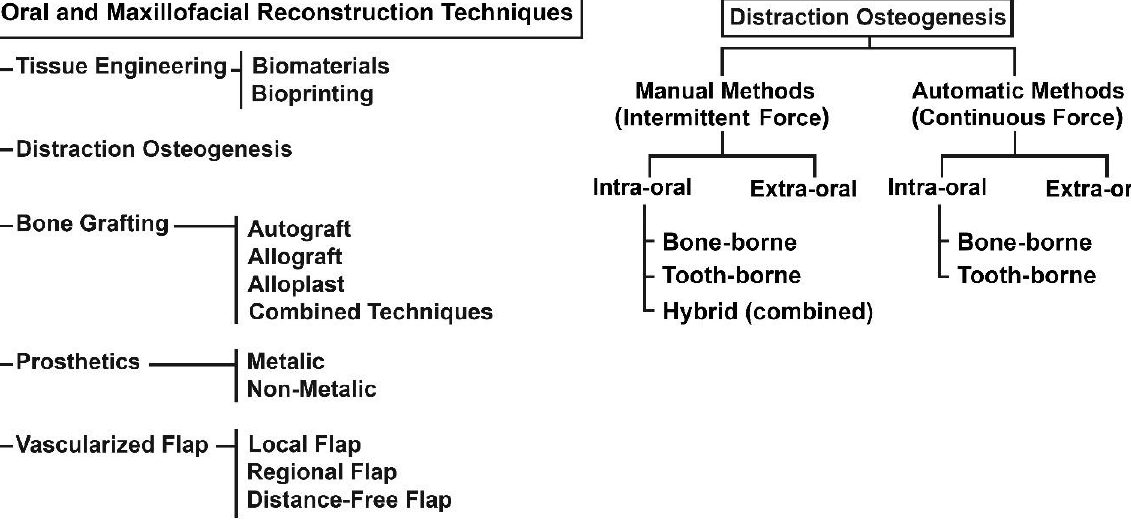
Figure 1. Oral and maxillofacial reconstruction techniques and the existing DO methods.